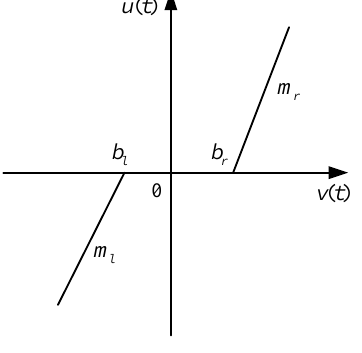
Figure 5. Dead-zone characteristic curve.